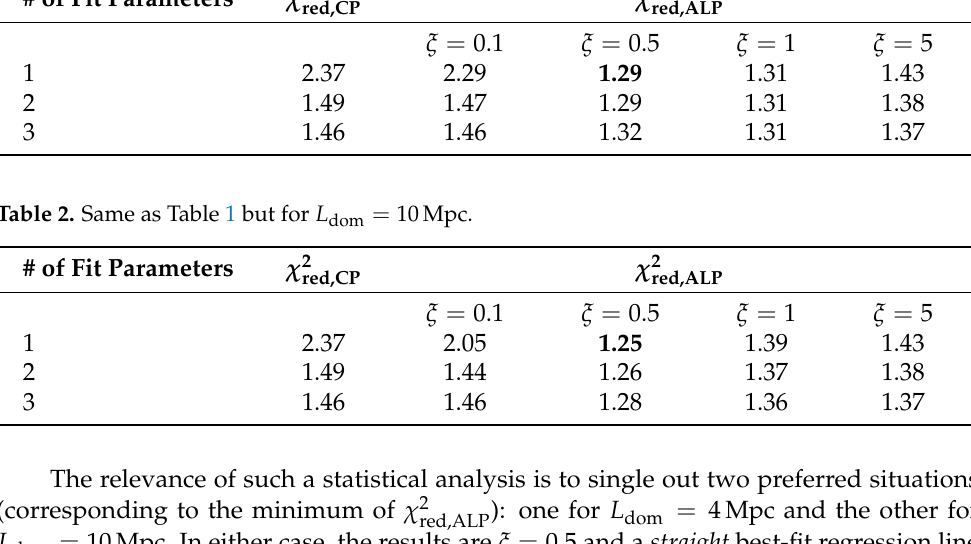
Table 1. Values of χ 2 in the case of conventional physics and χ 2 red,CP all blazars belonging to S . The first column indicates the number of fit parameters, the second column concerns conventional physics and the third column refers to the ALP scenario for L dom = 4Mpc and our benchmark values of ξ . The number in boldface corresponds to the minimum of χ 2 # of Fit Parameters